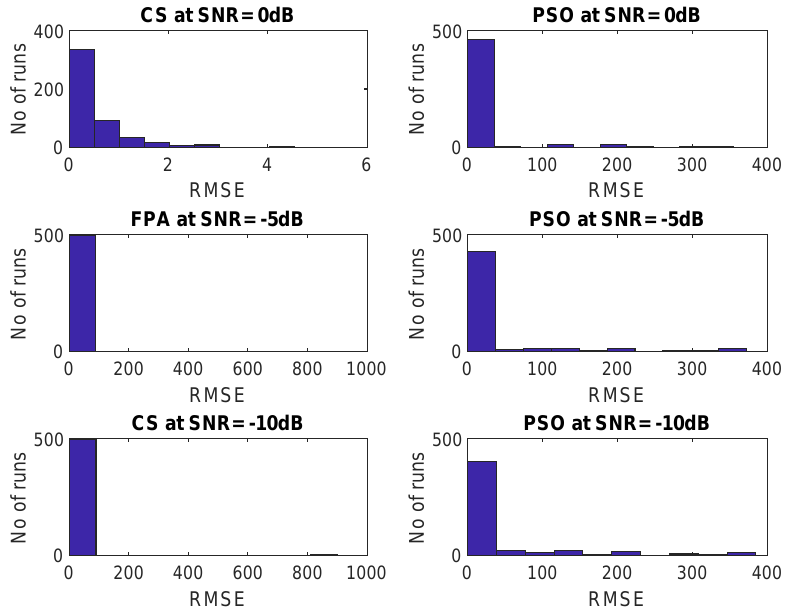
Figure 16. Correlation of proposed CS and PSO models based on RMSE using six